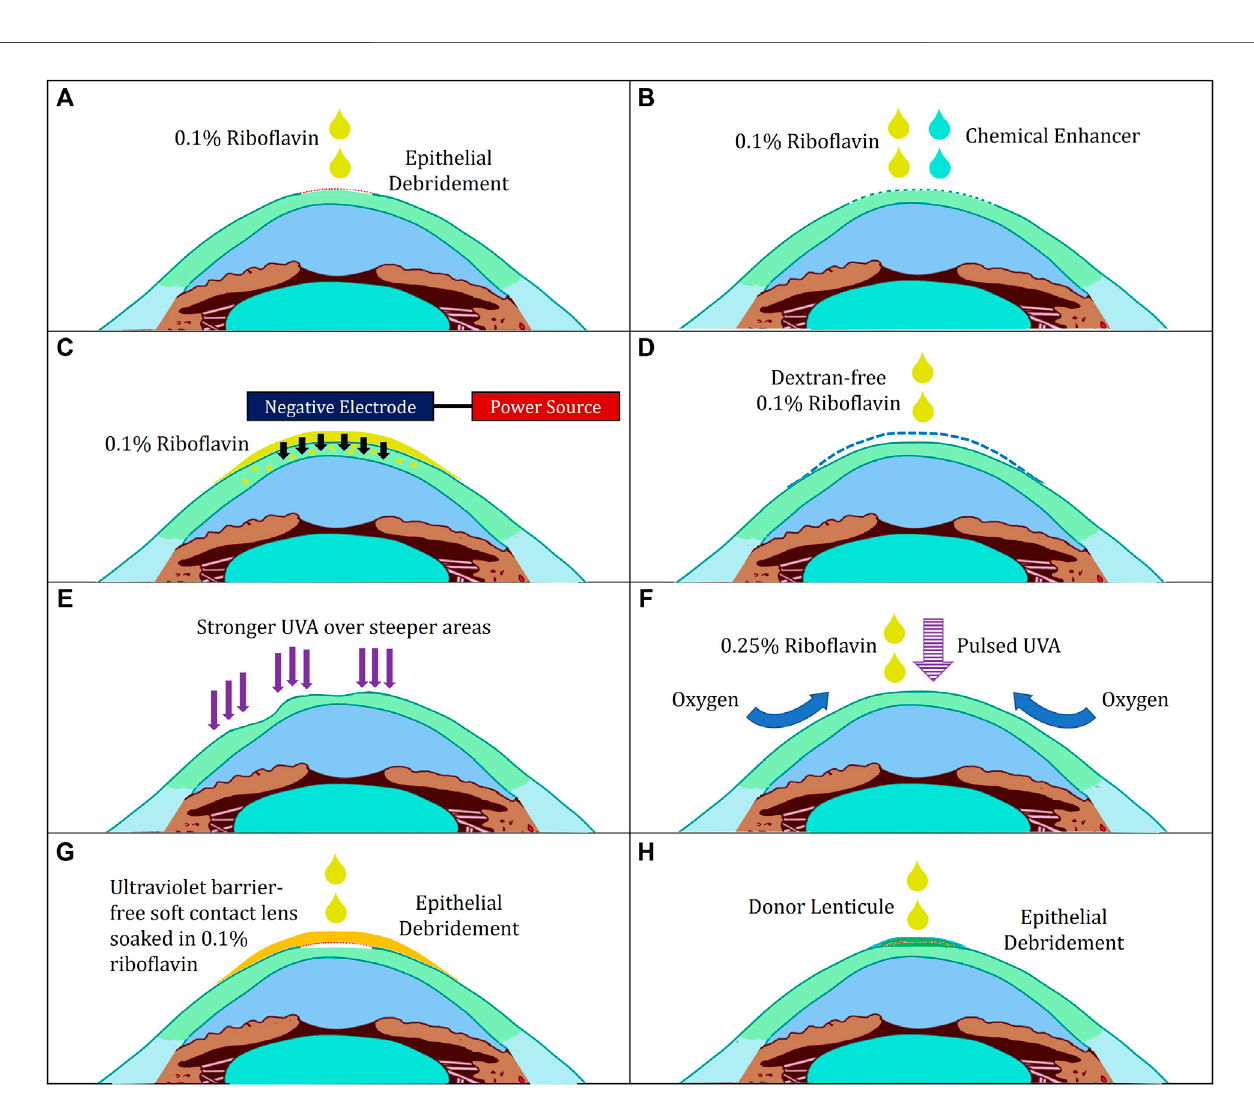
FIGURE 2 | Illustration of various modi fi cations to corneal cross-linking. (A) Standard “ epithelium-off ” Dresden Protocol (B) Transepithelial Protocol with Chemical Enhancers (C) Transepithelial Protocol with Iontophoresis (D) Hypoosmolar Ribo fl avin for Thin Corneas (E) Customised Protocol (F) Boost Epithelium-On Protocol (G) Contact-Lens Assisted Corneal Cross-Linking (H) Epi-Off-Lenticule-On Corneal Cross-linking.